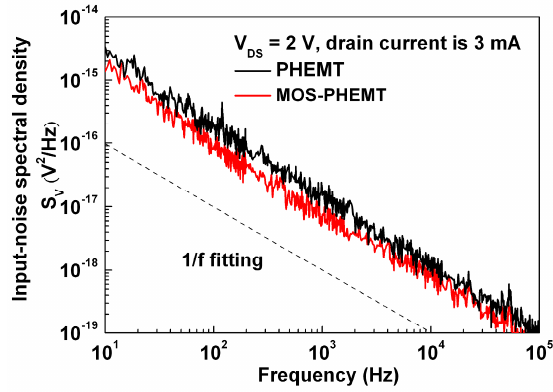
Figure 8. Comparison of low-frequency 1/f characteristics for both devices. Table 1. Summary of dc, low-frequency noise, and microwave characteristics of AlGaAs/InGaAs MOS-PHEMTs with similar structures but different types of gate oxides.